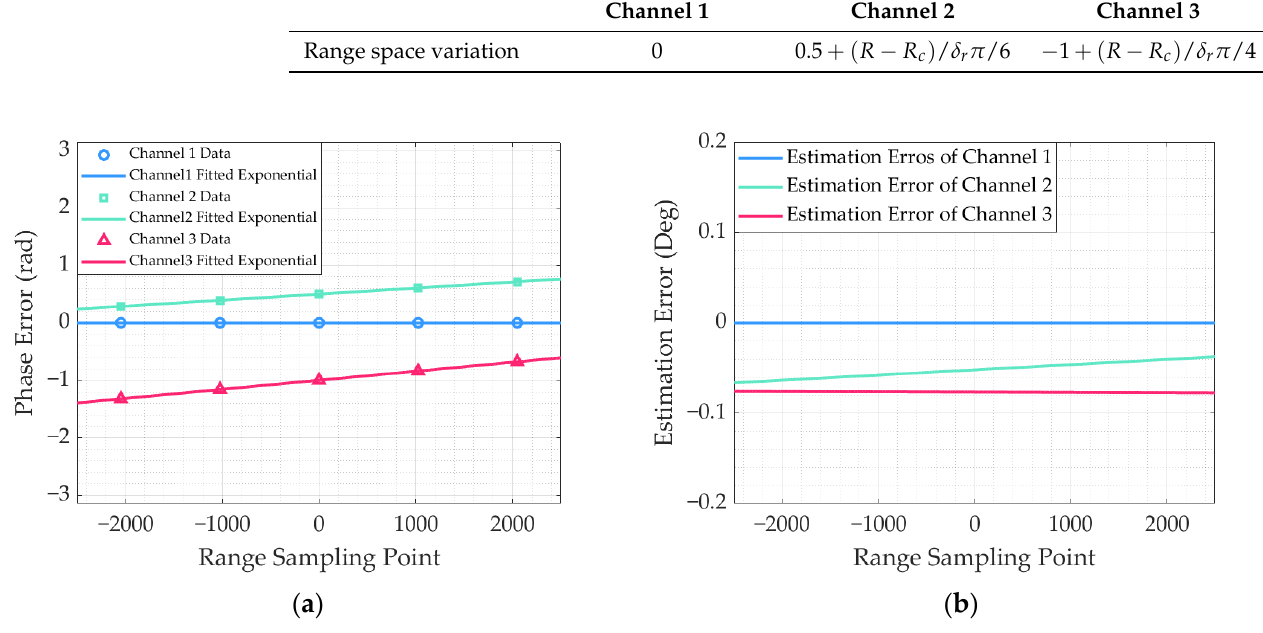
Figure 11. Range space-variant phase error estimation results. ( a ) Range chunking estimation and least-squares fitting results. ( b ) Estimation error of range linear space-variant